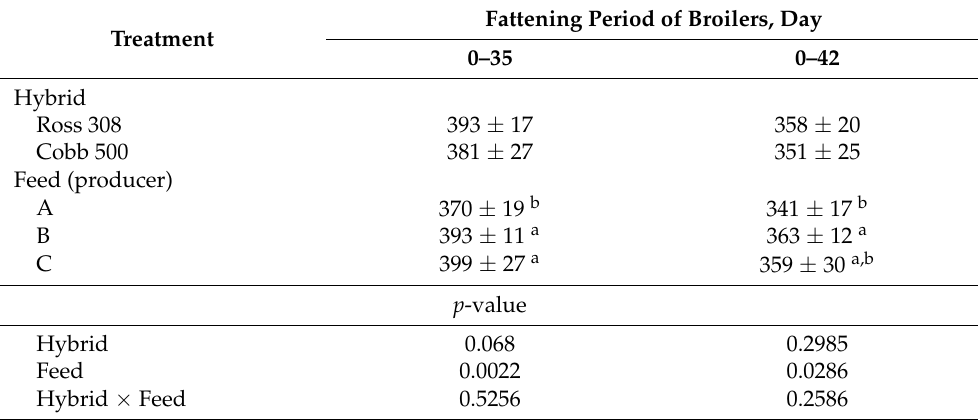
Table 6. Production index (EPEF) in test of fattening different hybrids with different market feeds (mean ± standard